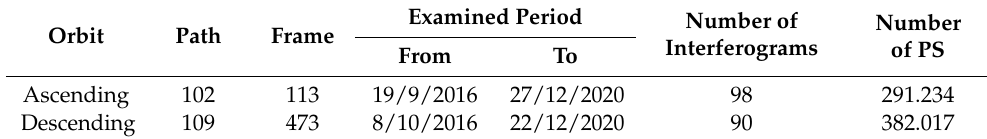
Table 1. Characteristics of the Sentinal-1 images processed and of the created products. Examined Period Number of Orbit Path Frame